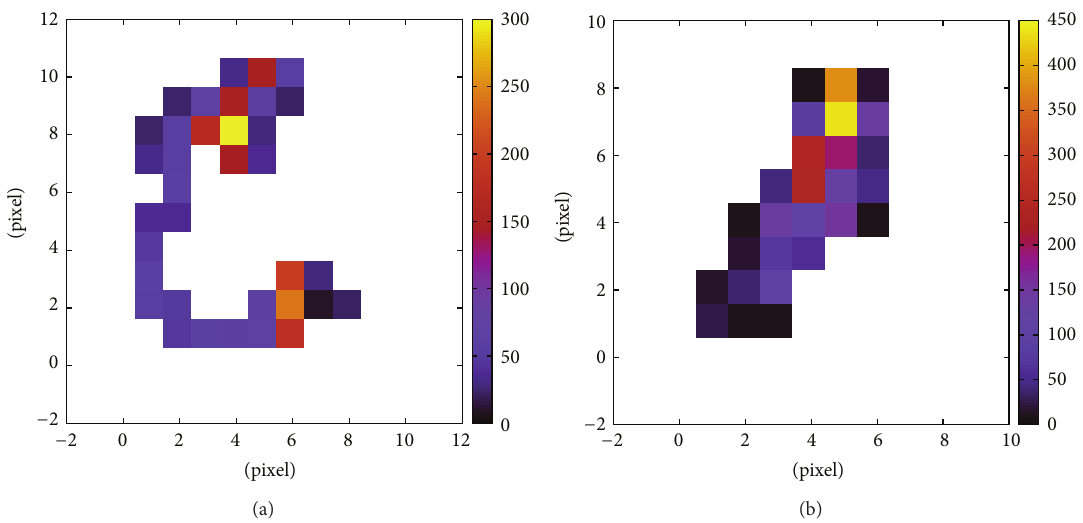
Figure 10: Simulated pattern of energy depositions in the pixel matrix for two examples of 0 ] 𝛽𝛽 -decay events. (a) Clear 0 ] 𝛽𝛽 -decay appearance. (b) event that looks like a single-electron track. The 𝑥 - and 𝑦 -coordinates give the pixel row and column. The color bar encodes the energy deposition measured with the time-over-threshold method in keV.